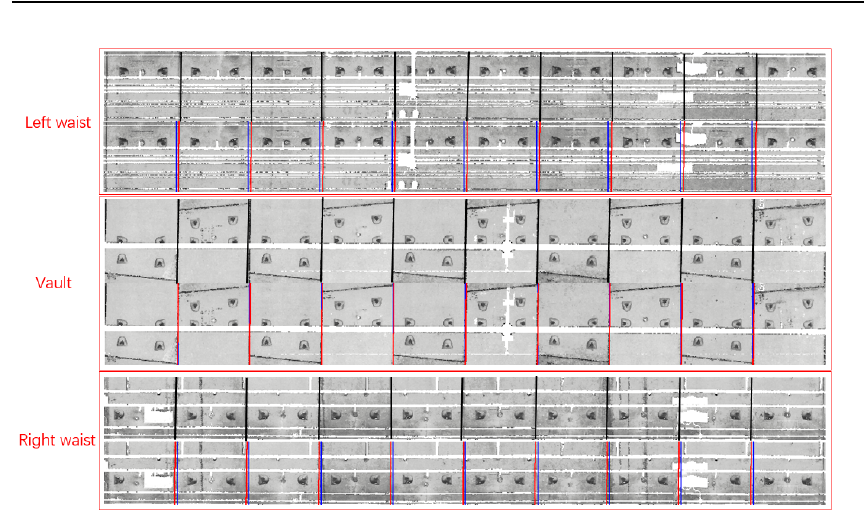
Figure 16. Comparison of circumferential seam positioning. Black, red, and blue lines are the circumferential seams in the point cloud, positioned by the proposed method, and positioned by Du et al.’s method, respectively.